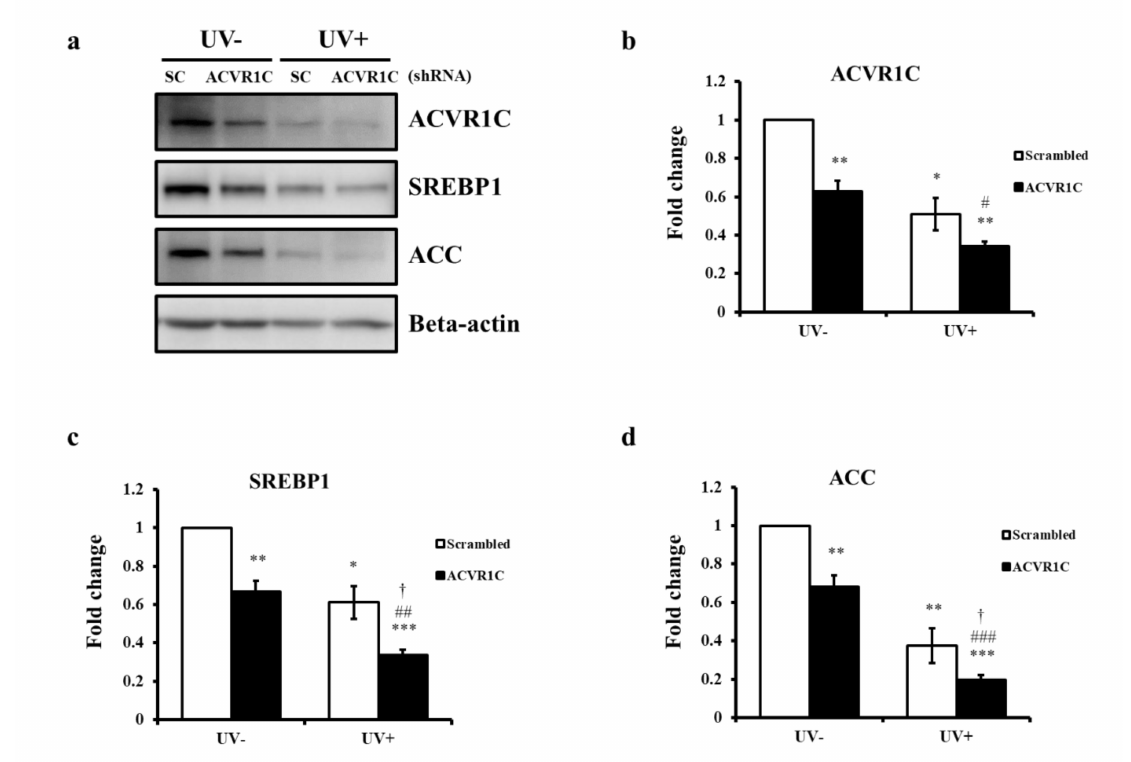
Figure 3. Knockdown of ACVR1C decreases the expression of SREBP1 and ACC in both non-irradiated and UV-irradiated primary NHEK. Primary NHEK were transfected with ACVR1C or scrambled shRNA and then irradiated with UV (75 mJ/cm 2 ). ( a ) ACVR1C, SREBP1, and ACC protein levels were measured by Western blotting at 24 h after UV irradiation and ( b – d ) protein levels were quantified using ImageJ. β -actin was used as a loading control (n = 4). * p < 0.05, ** p < 0.01, *** p < 0.001 vs. non-irradiated scrambled shRNA; # p < 0.05, ## p < 0.01, and ### p < 0.001 vs. non-irradiated ACVR1C shRNA; † p < 0.05 vs. UV-irradiated scrambled